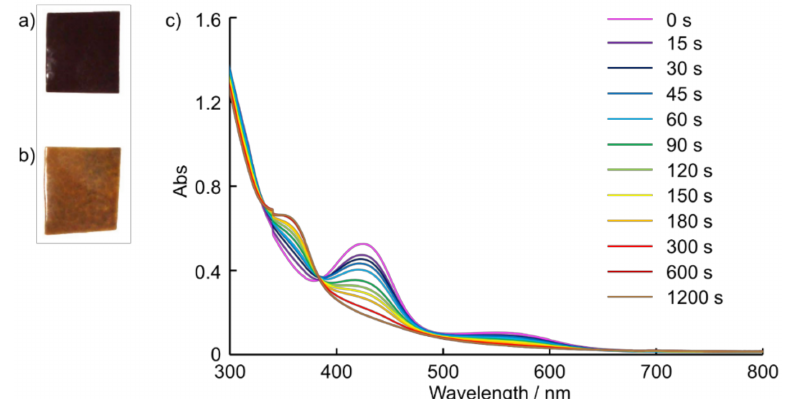
Figure 5. Photographs of ( a ) 1e /polysiloxane self-standing composite film (thickness: 0.497 mm) and ( b ) 2e /polysiloxane composite film, which was prepared by exposure of the 1e /polysiloxane composite to CO gas. ( c ) UV-Vis spectral changes of the 1e /polysiloxane self-standing composite film during exposure to CO